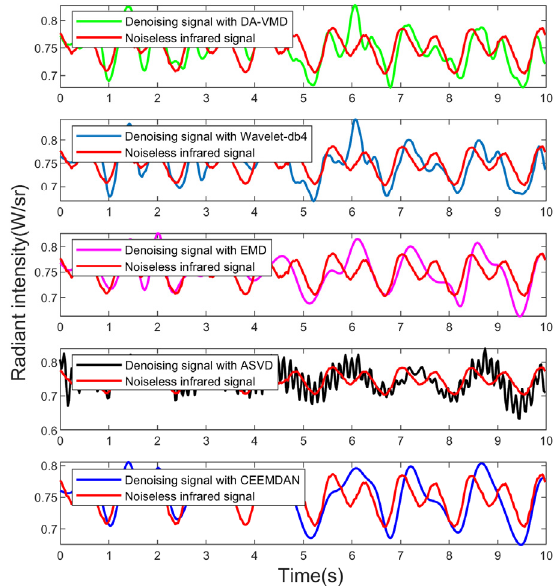
Figure 18. Denoising signal of different denoising methods with SNR = 10 (8–11.7 µm).